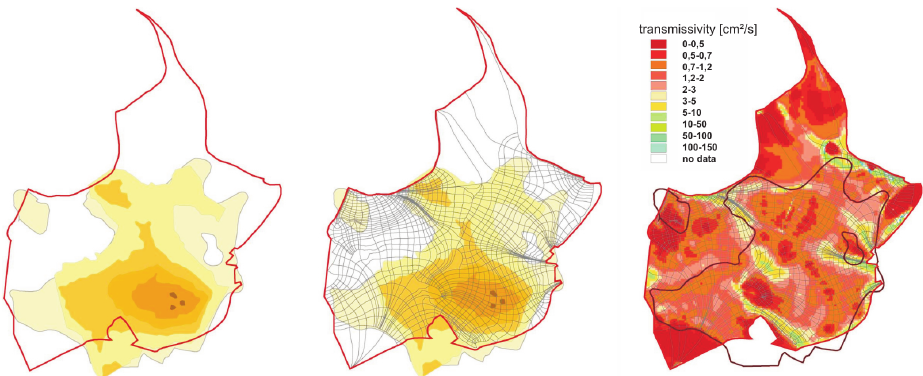
Fig. 1. Hydromorphological analysis for the mire “Mothh¨auser Haide” (Ore Mountains, 770mHN; left: catchment (red line) and peat depth (yellow: thin, orange: thick, red: up to 8m); middle: constructed streamlines and segments; right: map of potential transmissivity (red-dry, green-wet).